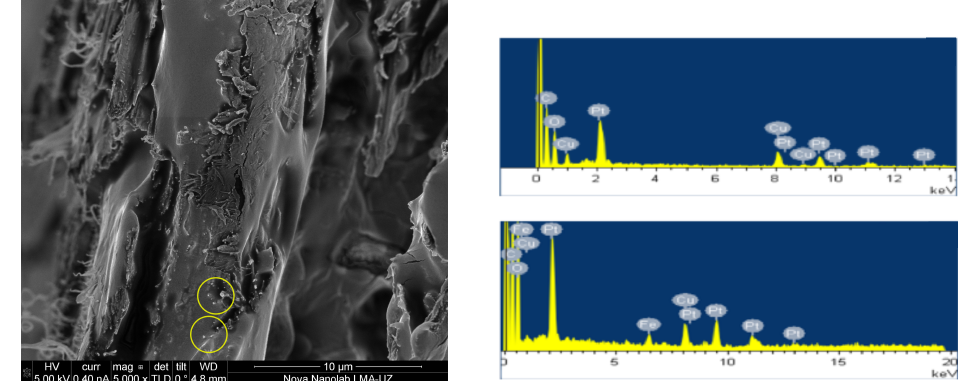
Figure 3. Left : Cryo-SEM image of the NF-impregnated Kraft paper (yellow circles mark images identified as NPs). Right : EDX spectra of an MO-impregnated paper ( top ) and NF-impregnated paper ( bottom